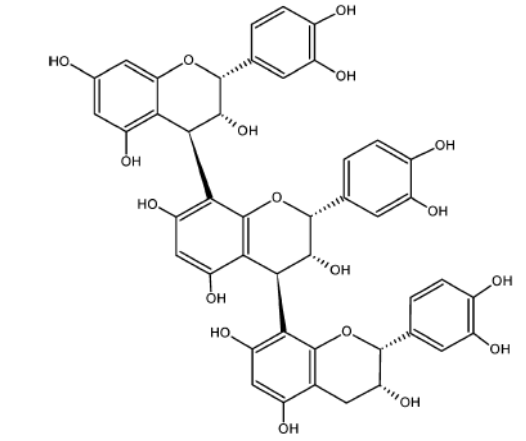
Figure 3. Structures of procyanidin dimer and trimer in cocoa